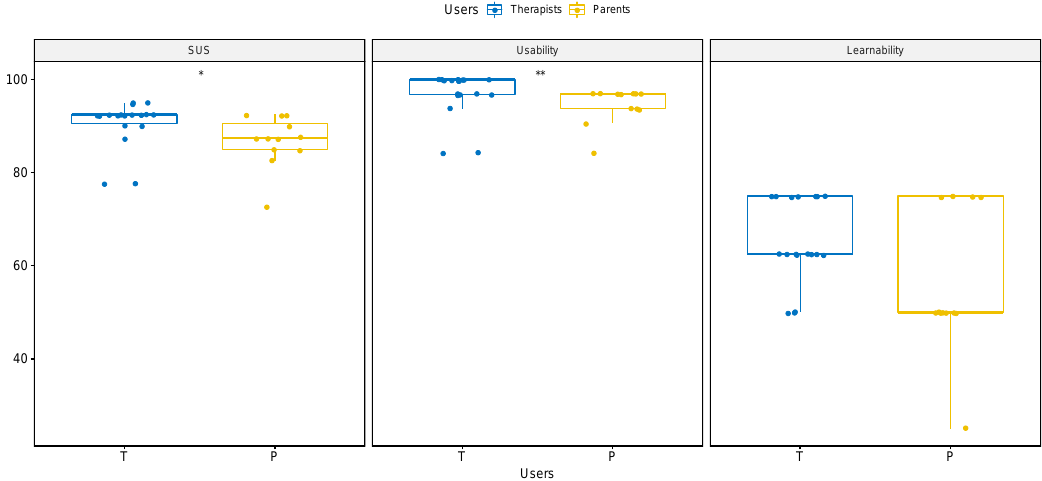
Figure 4. Comparison of mean scores between the two user groups. The figure reports the Mann–Whitney U test results, comparing the two user groups, therapists and parents, using the SUS, usability, and learnability scales. A significant statistical difference was detected only for the SUS (* = p < 0.05) and usability (** = p <